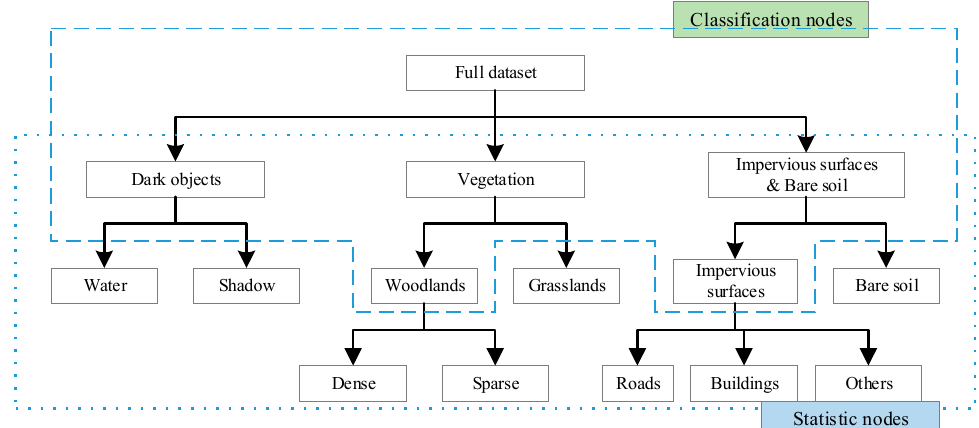
Figure 6. The class tree of land cover types.